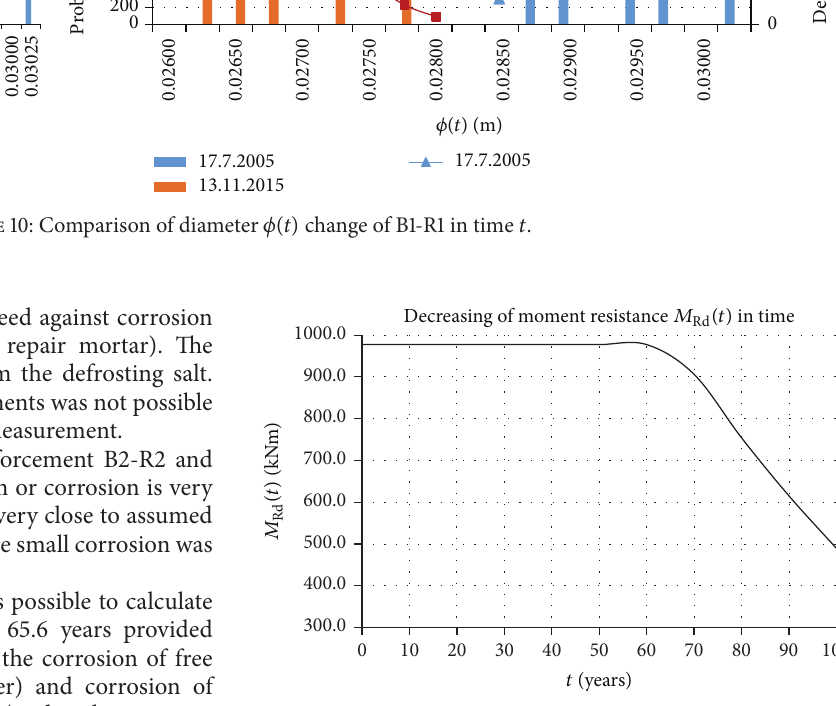
Figure11:Changeofmomentresistance 𝑀 Rd (𝑡) intimeofRCbridge girder due to the reinforcement